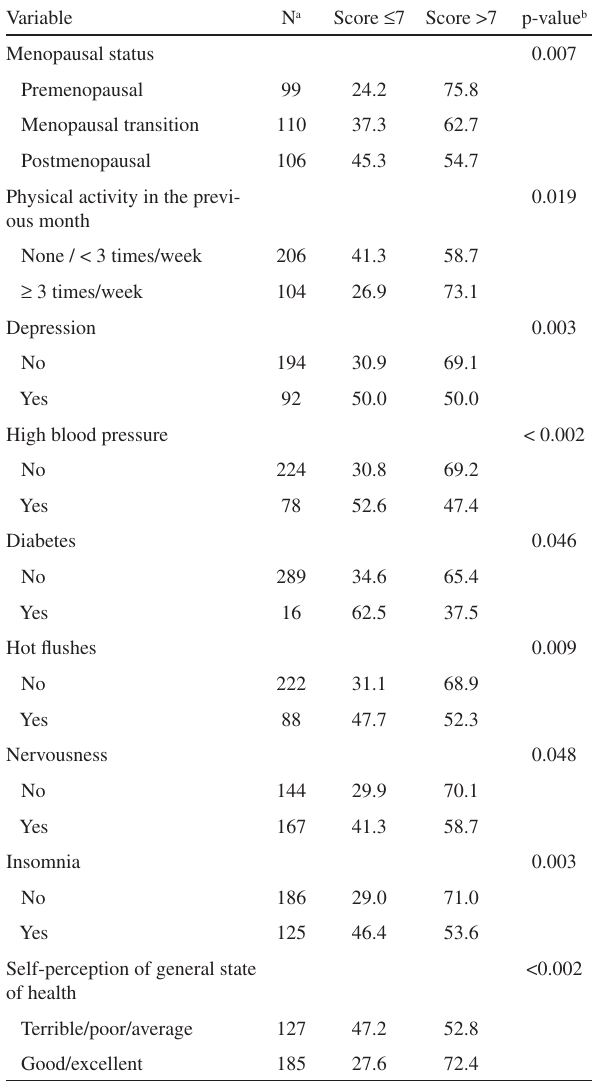
Table 1 - Variables associated with the sexual dysfunction (SPEQ score ≤ 7) of middle-aged women - Bivariate analy- sis Variable